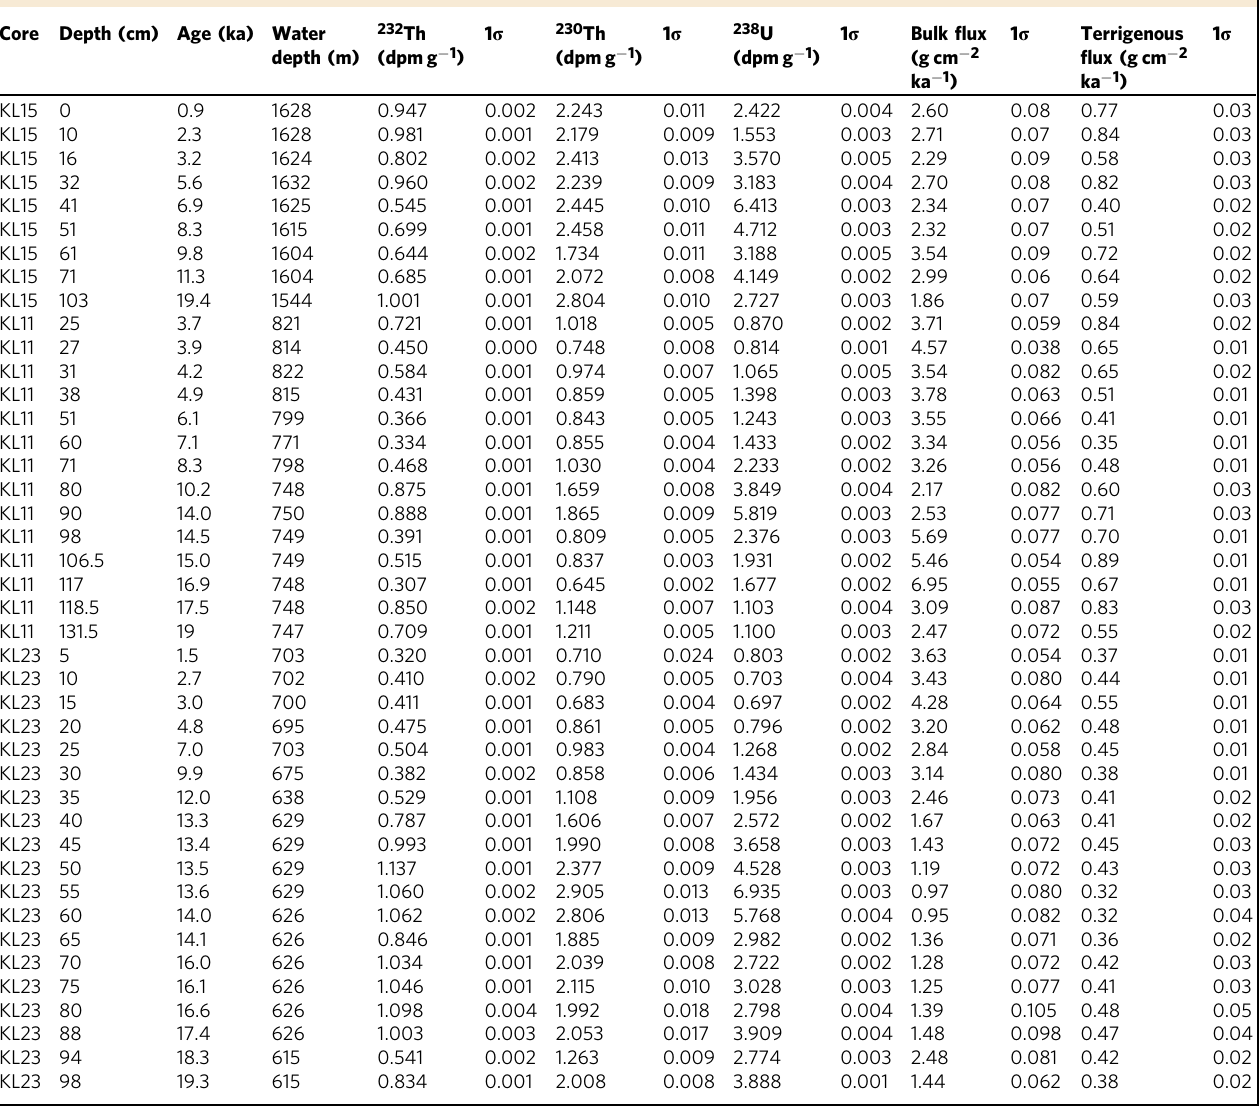
Table 2 Sediment mass accumulation rates in the Red Sea and Gulf of Aden